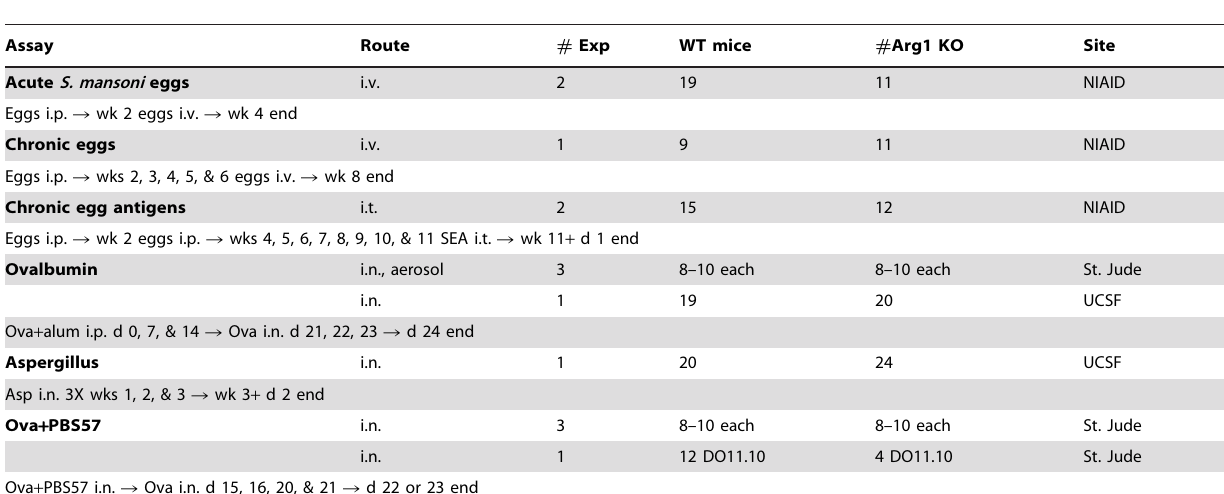
Table 1. Experimental lung inflammation models performed in this